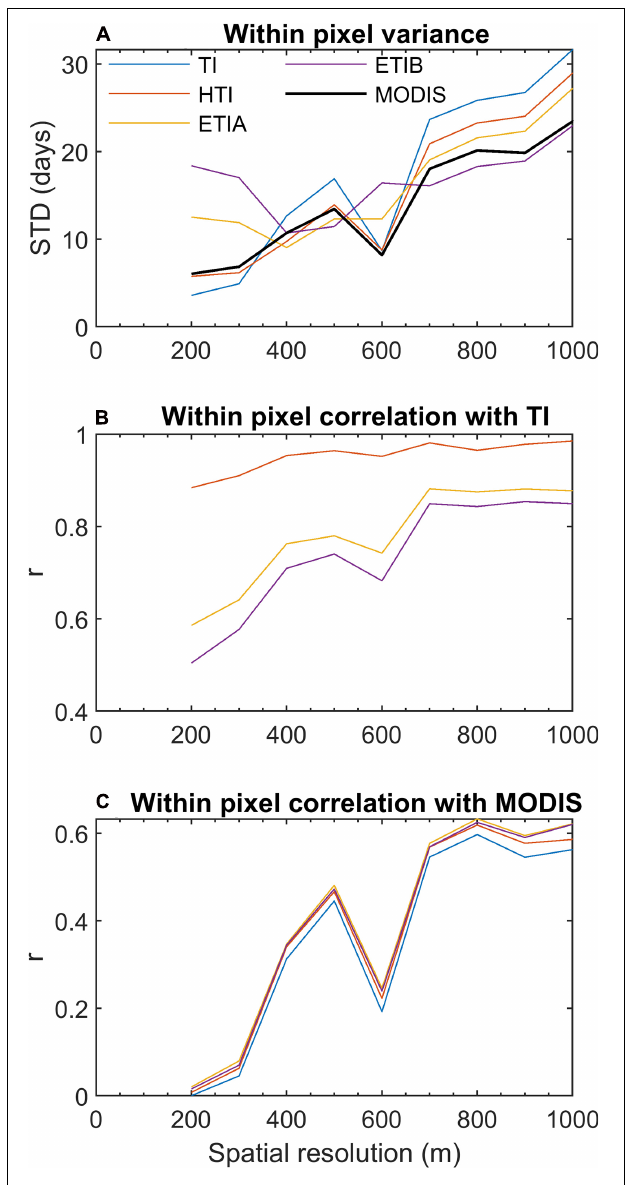
FIGURE 11 | Scale analysis of snow cover duration (SCD, in days). (A) Subgrid (within pixel) variability (standard deviation) of simulated SCD at increasing aggregation scales. (B) Subgrid correlation between SCD simulated by the enhanced models and the reference TI model at increasing aggregation scales. (C) Subgrid correlation between SCD simulated by all models and MODIS SCD (resampled to 100 m resolution) at increasing aggregation scales.